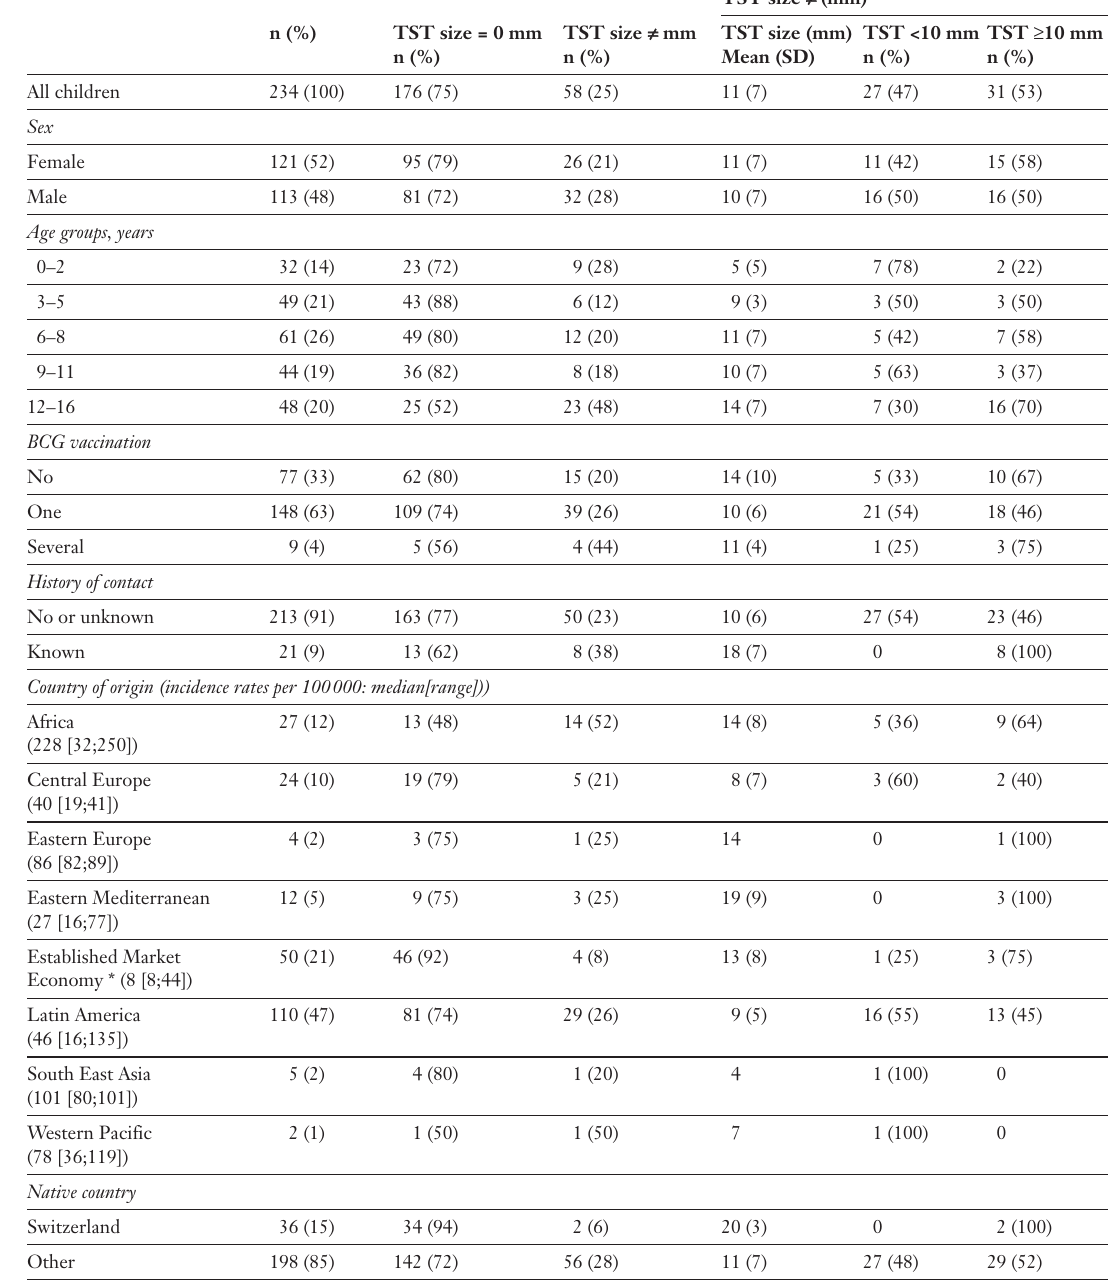
Descriptive analysis of the study popula- tion.